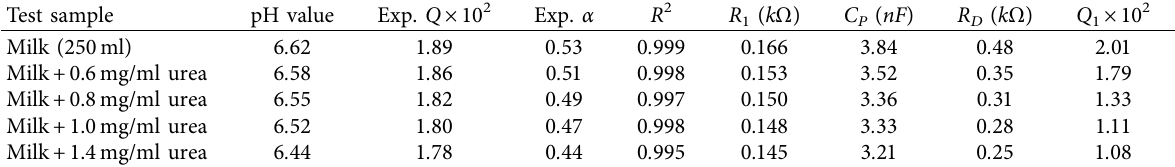
Table 1: Fitting parameters of the FOE13 sensor dipped in urea adulterated milk.